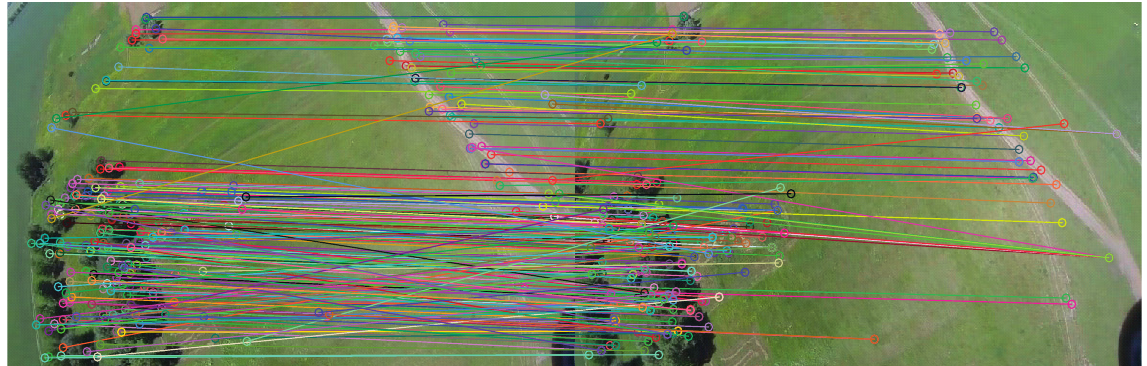
secFig. 4. The matching of two video frames from aboard a UAS with a difference of 10 frames (0.4 sec, 25 fps) done in (Code… 2013). The number of false matching is 126 from a total of 189 matching features. The average time for computing the matches is 0.0499 sec